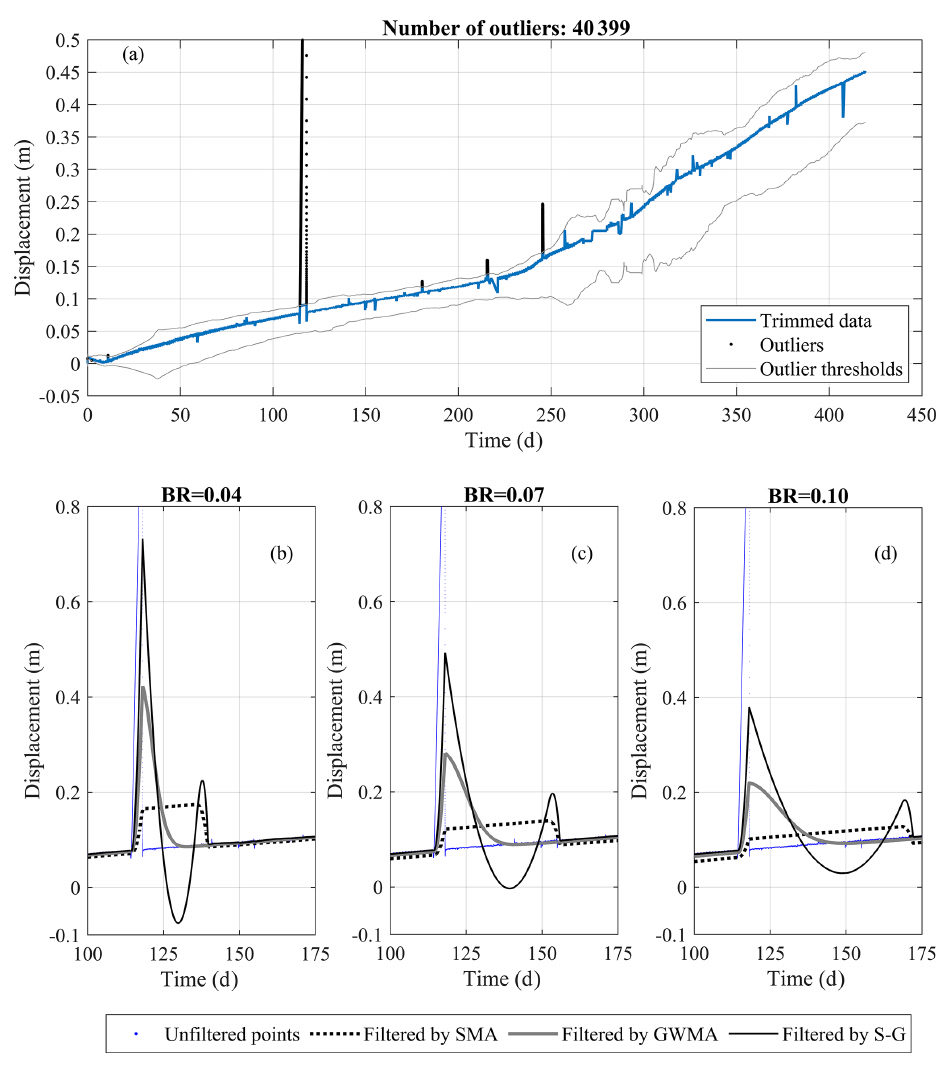
Figure 18. Unfiltered and filtered displacement measurements for Geocube 47 at bandwidth ratios (BRs) of (a) 0.04, (b) 0.07, and (c)